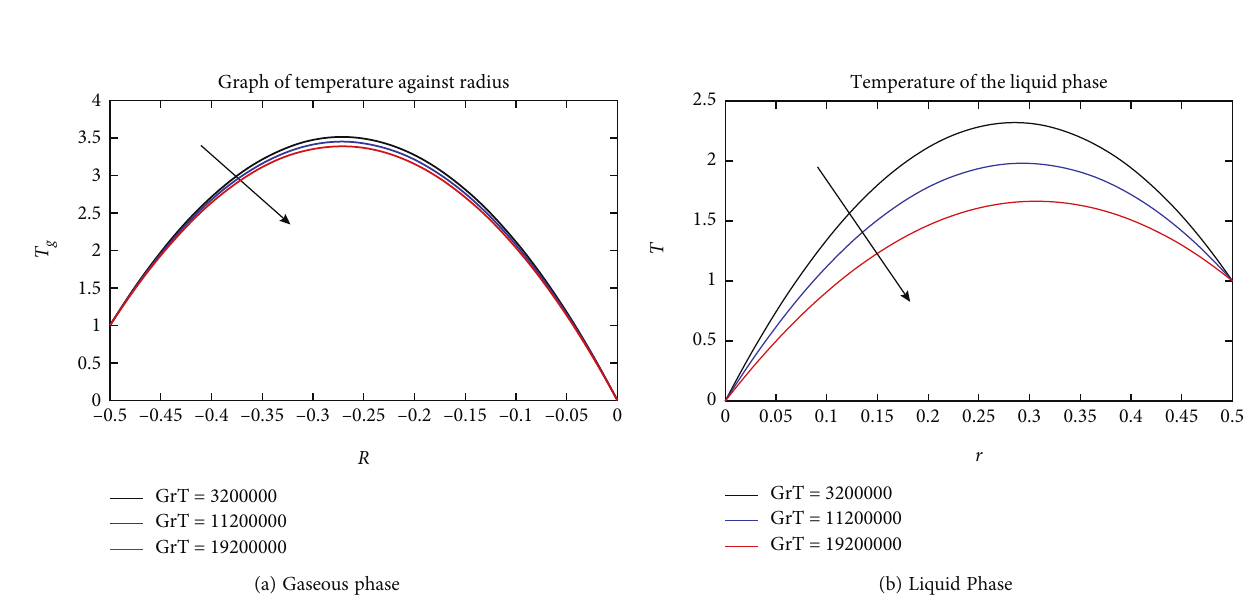
Figure 9: E ff ect of Thermal Grasholf Number on Temperature Pro fi